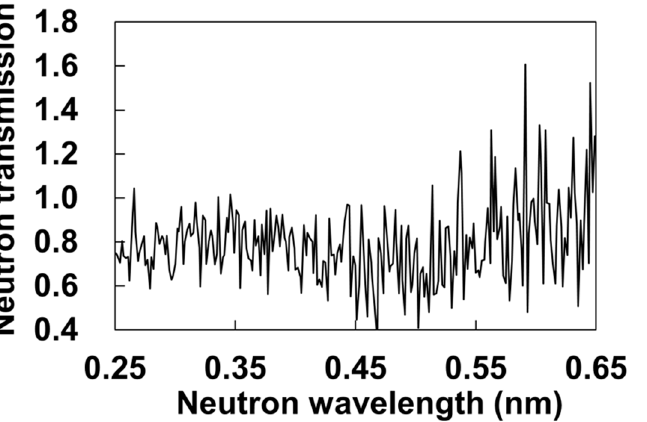
Figure 12. Example of neutron transmission spectrum analyzed by ML analysis. It shows one-pixel data of the liquid-phase zone from the start of the solidification process to 30 min later.